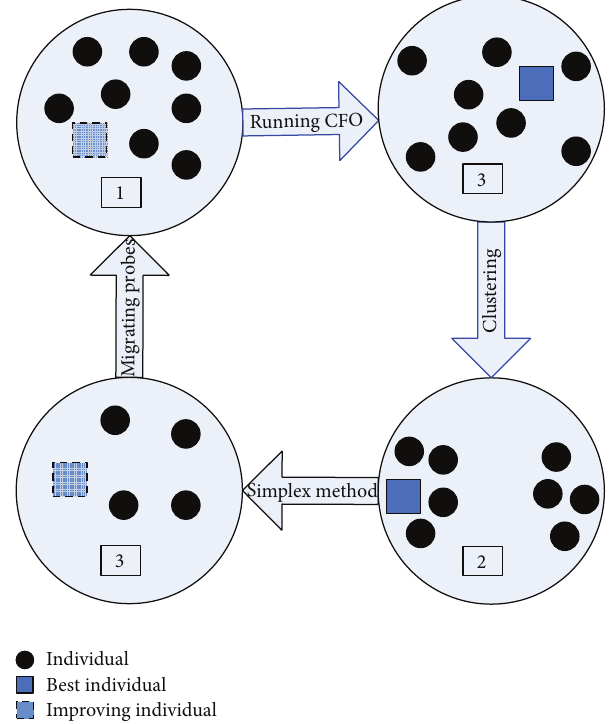
Figure 1: Model of CSM-CFO